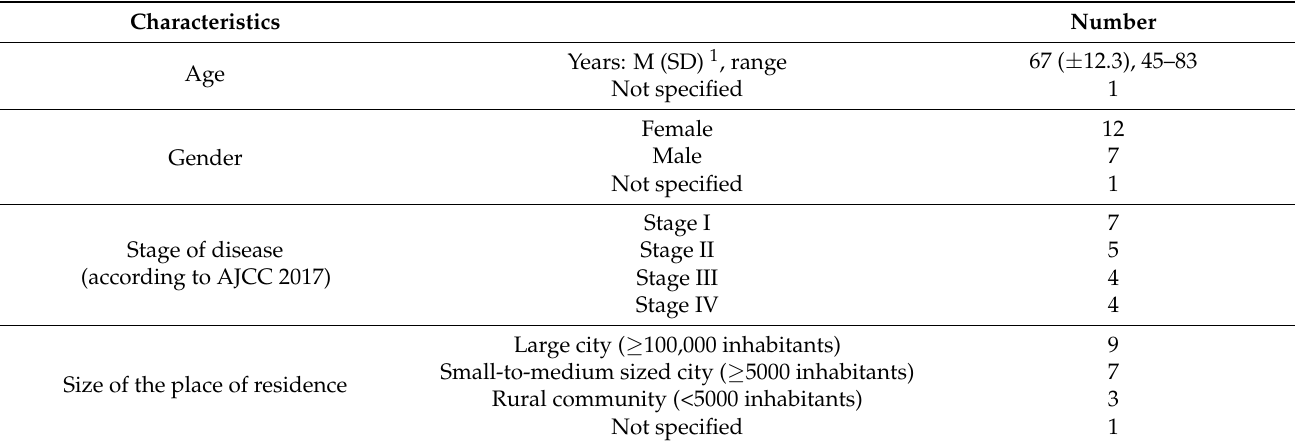
Table 1. Characteristics of the patients participating in the focus groups (n = 20